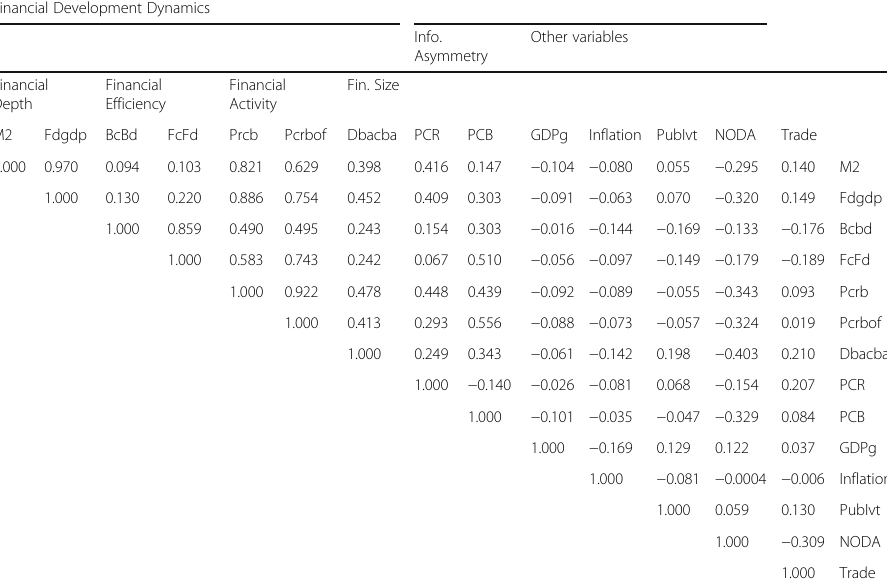
Table 10 Correlation Analysis (Uniform sample size: 291) Financial Development